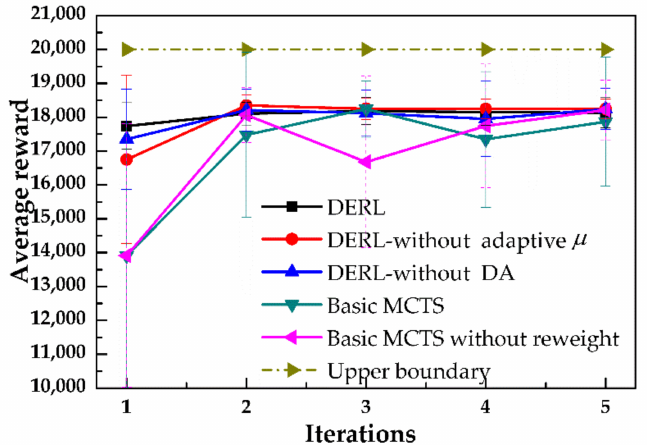
Figure 11. Average reward over 25 initial parking position during the learning processes of di ff erent algorithms where DERL is the proposed complete method. One iteration is equal to 25 parking trials.